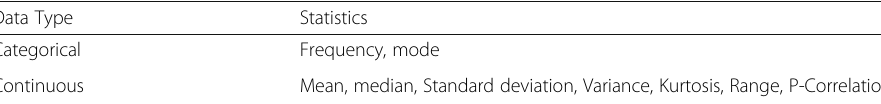
Table 9 Descriptive Analysis